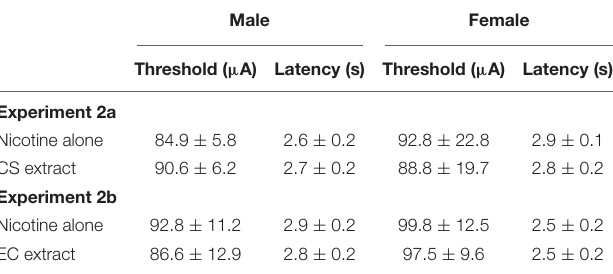
TABLE 1 | Mean ( ± SEM) baseline ICSS thresholds (in µ A) and response latencies (in s) in males and females during nicotine alone and CS or EC extract testing in Experiments 2a and 2b.